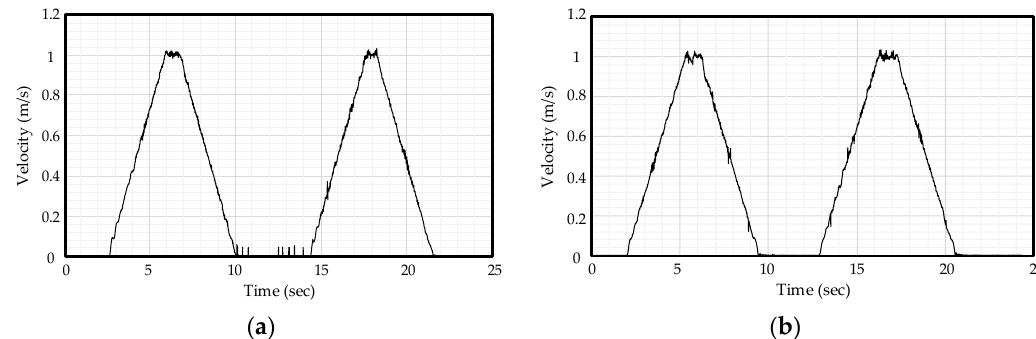
Figure 19. ( a ) Velocity measurement result of Vicon; ( b ) velocity measurement result of proposed readout IC converted from digital codes to analog signal.